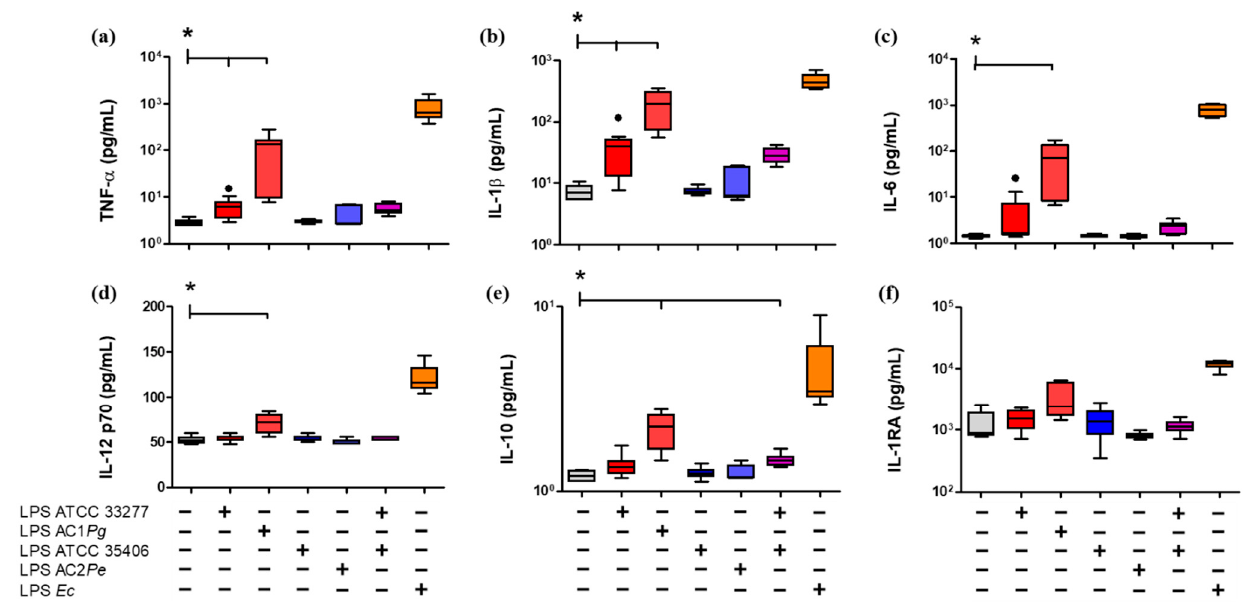
Figure 3. Cytokine secretion LPS-stimulated macrophages in vitro. Box and whisker plots represent the median and interquartile range of pro-inflammatory cytokines ( a ) TNF- α , ( b ) IL-1 β , ( c ) IL-6, and ( d ) IL-12p70, and anti-inflammatory cytokines ( e ) IL-10 and ( f ) IL-1RA, detected in the supernatant of THP-1 macrophages in vitro culture stimulated for 24 h with LPS. U/S Unstained. Experiments were performed in triplicate. Data were analyzed by the Kruskal-Wallis test. ( ● ) Represents outlier data. ( n = 3) * p < 0.05.